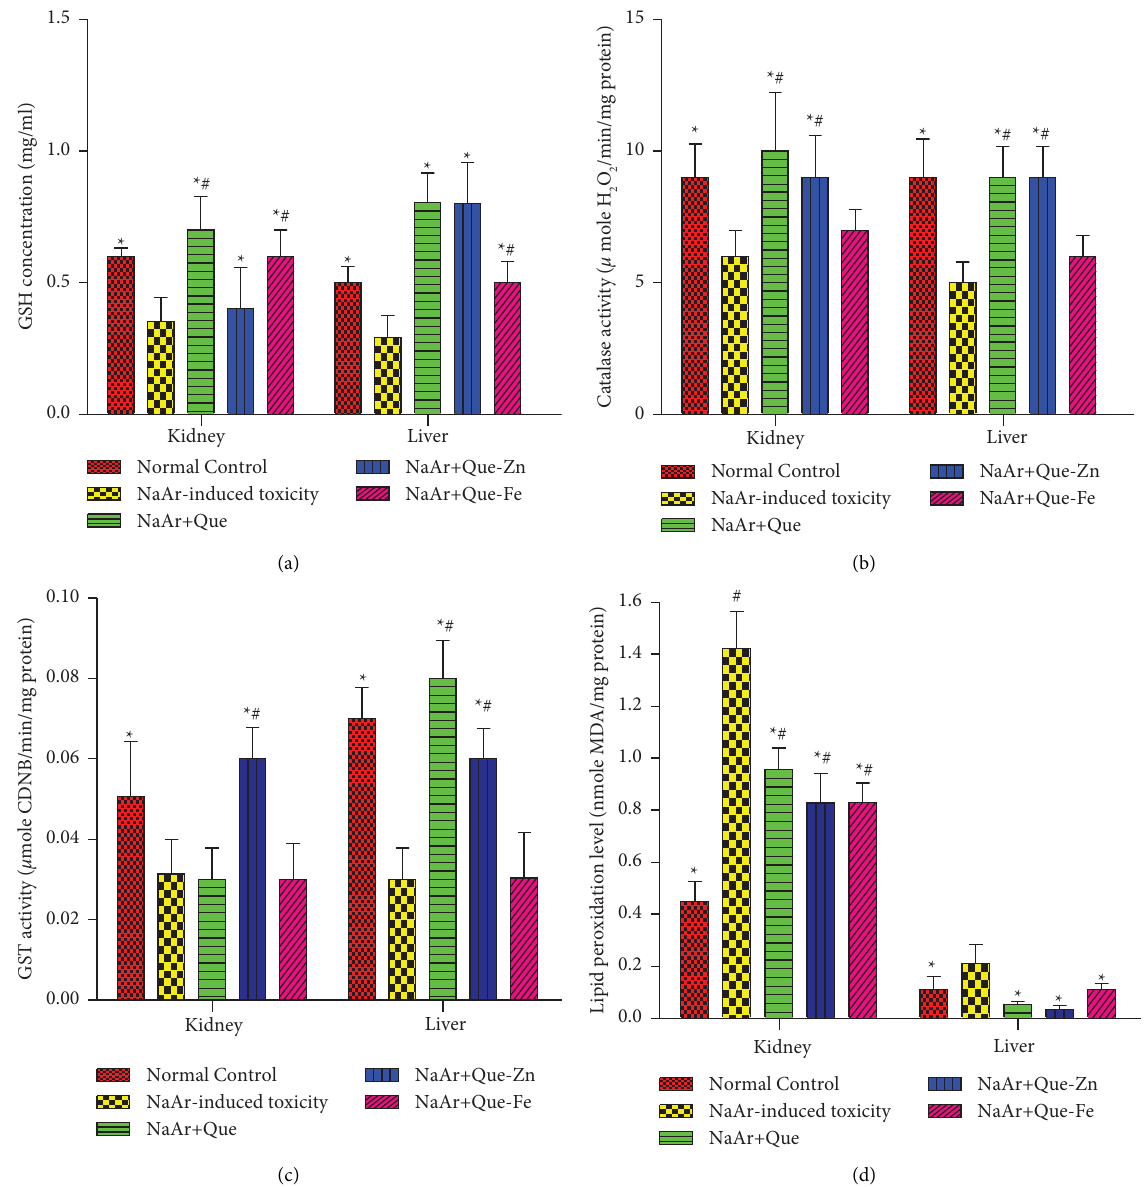
Figure 5: (a) Quercetin and its metal complexes increased glutathione-S-transferase in the liver and kidney of sodium-arsenite induced intoxicated rats. (b) Quercetin and its metal complexes normalized CATactivity in the liver and kidney of sodium-arsenite intoxicated rats. (c) Quercetin and its metal complexes increased glutathione concentration in the liver and kidney of sodium arsenate intoxicated rats. (d) Quercetin and its metal complexes inhibited lipid peroxidation in the liver and kidney of sodium arsenite intoxicated rats. Data are presented as the mean ± SD, ∗ � values difer signifcantly from untreated sodium arsenite-intoxicated rats ( P < 0 . 05), # � values difer signifcantly from normal control rats ( P < 0 . 05), normal control, NaAr-induced toxicity � rats administered sodium arsenite and left untreated, NaAr+Quer � rats administered sodium arsenite and treated with 30mg/kg quercetin, NaAr +Quer-Zn � rats administered sodium arsenite and treated with 30mg/kg quercetin-zinc, and NaAr+Quer-Fe � rats administered sodium arsenite and treated with 30mg/ kg